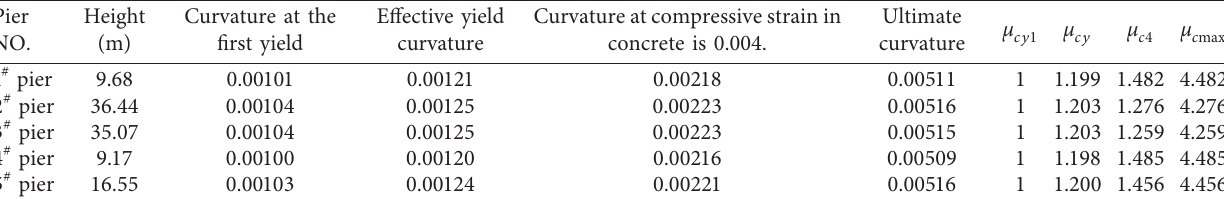
Table 3: Damage indexes of five piers.